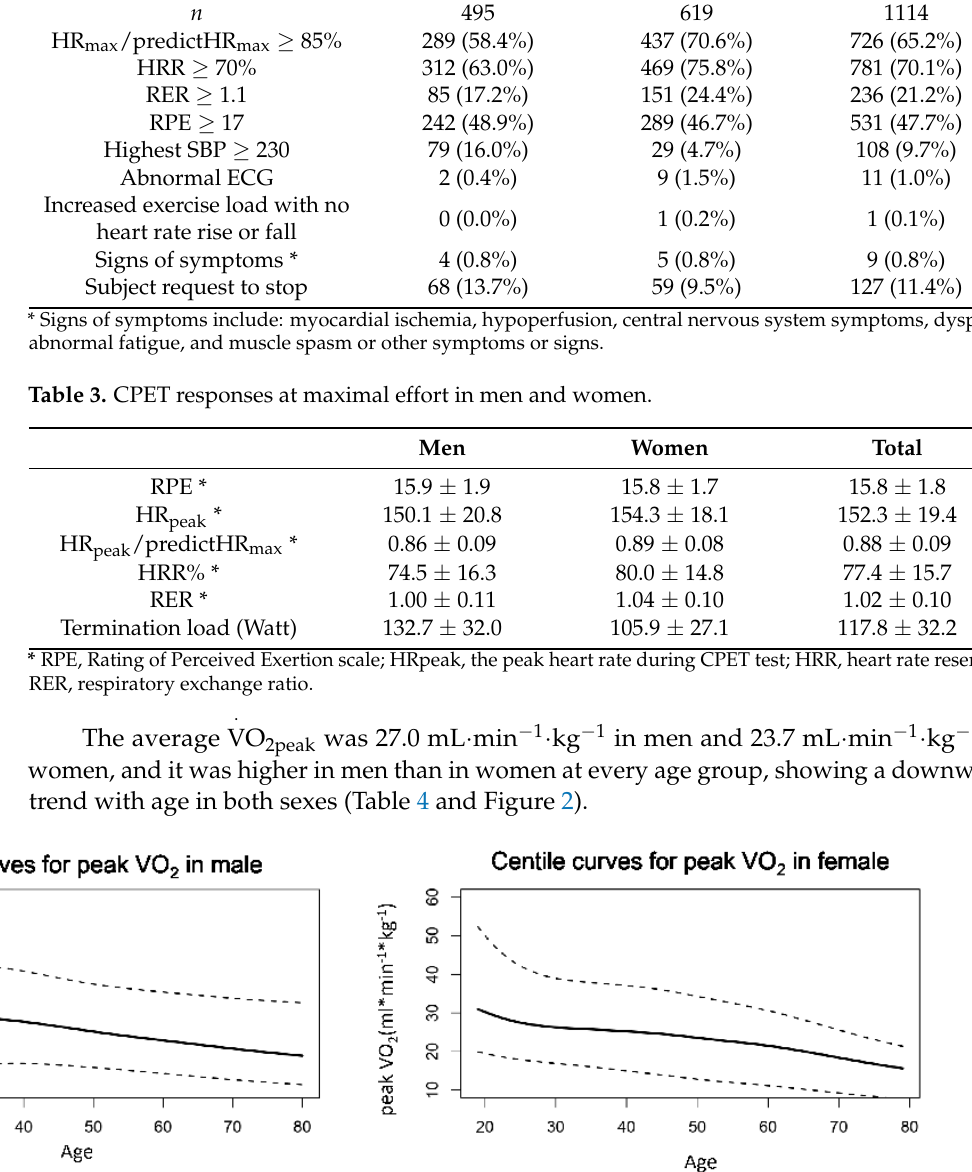
· VO 2peak and · O 2peak and